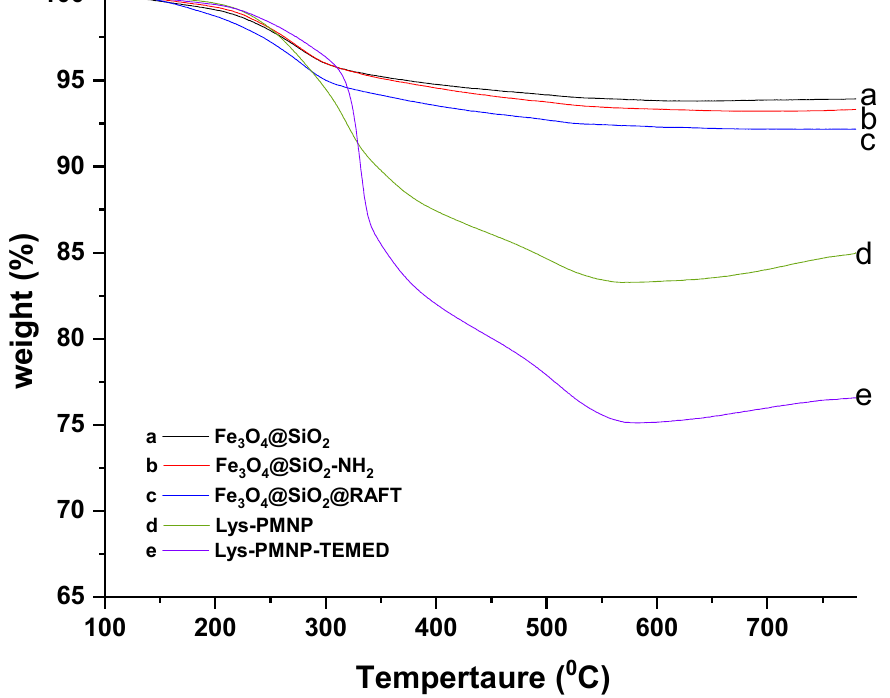
Figure 3. TG curves of Fe 3 O 4 @SiO 2 ( a ), Fe 3 O 4 @SiO 2 -NH 2 ( b ), Fe 3 O 4 @SiO 2 @RAFT ( c ), Lys-PMNP ( d ) and Lys-PMNP-TEMED ( e ). Fe 3 O 4 @SiO 2 , Fe 3 O 4 @SiO 2 -NH 2 and Fe 3 O 4 @SiO 2 @RAFT showed a weight loss